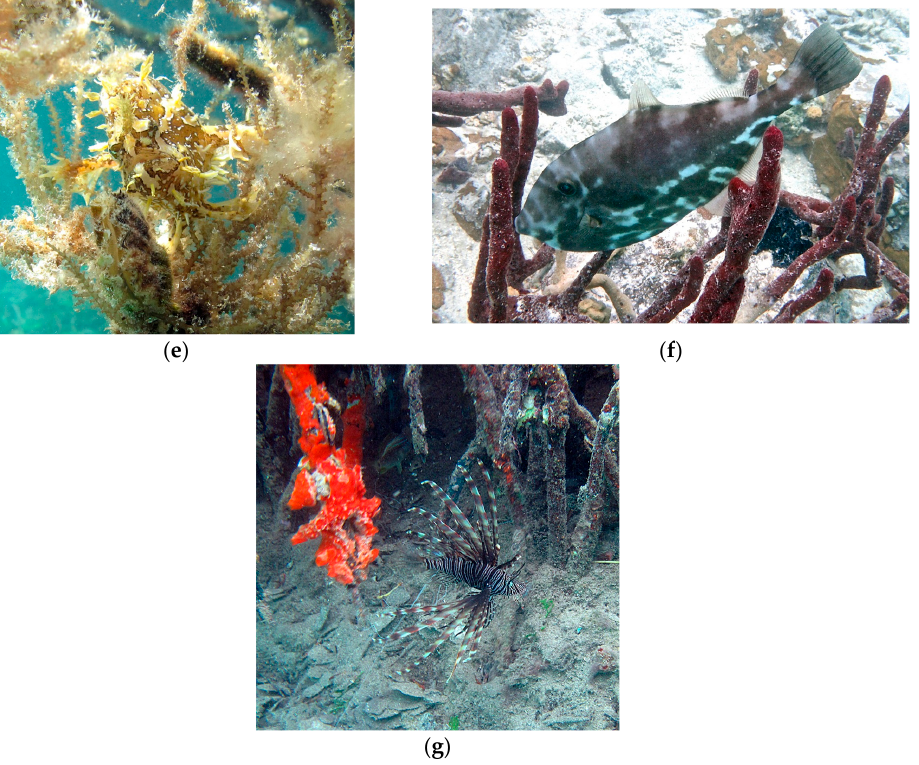
Figure 7. Fishes observed in Hurricane Hole’s mangrove-lined bays. ( a ) Gray Snappers ( Lutjanus griseus ); ( b ) Queen Angelfish ( Holocanthus ciliarus ); ( c ) Grunts ( Haemulon spp.); ( d ) Spotted Trunkfish ( Lactophrys bicaudalis ); ( e ) Sargassum Frogfish ( Histrio histrio ); ( f ) Unicorn Filefish ( Aluterus monoceros ) near red sponges ( Amphimedon compressa ); ( g ) Red Lionfish ( Pterois volitans ).